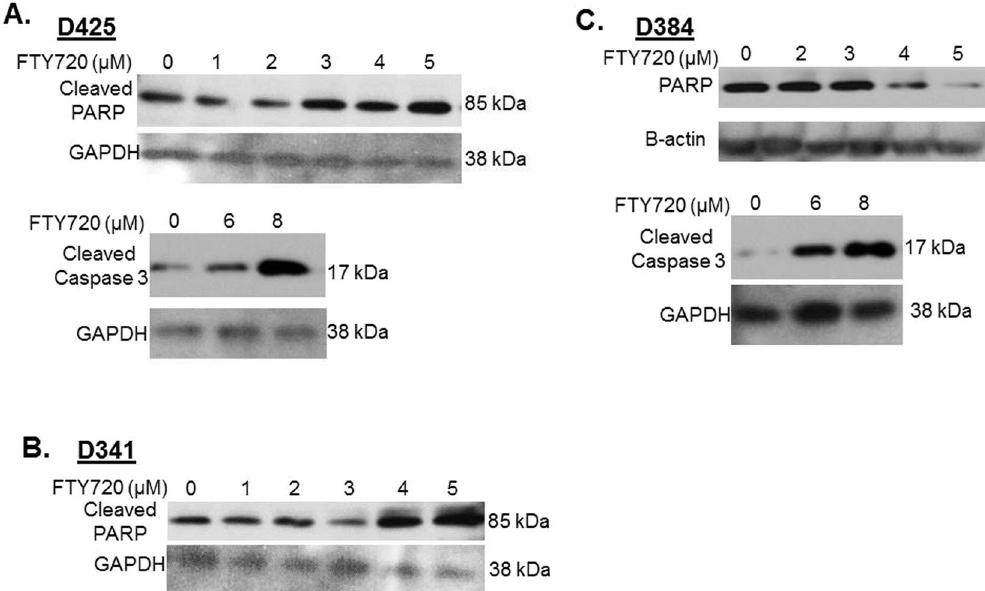
Figure 4. FTY720 treatment resulted in apoptosis of medulloblastoma PDX cells. Western blotting for cleaved PARP, total PARP, and cleaved caspase 3 of whole cell lysates from medulloblastoma PDX cells treated with increasing concentrations of FTY720. ( A ) In D425 cells, FTY720 resulted in increased cleaved PARP and increased caspase 3 indicating apoptosis. ( B ) In D341 cells, increasing concentrations of FTY720 led to increased cleaved PARP, again indicating apoptosis. ( C ) D384 cells, treated with increasing concentrations of FTY720, showed decreased total PARP and increased cleaved caspase 3, both indicating apoptosis. Β -actin or GAPDH was utilized to demonstrate equal protein